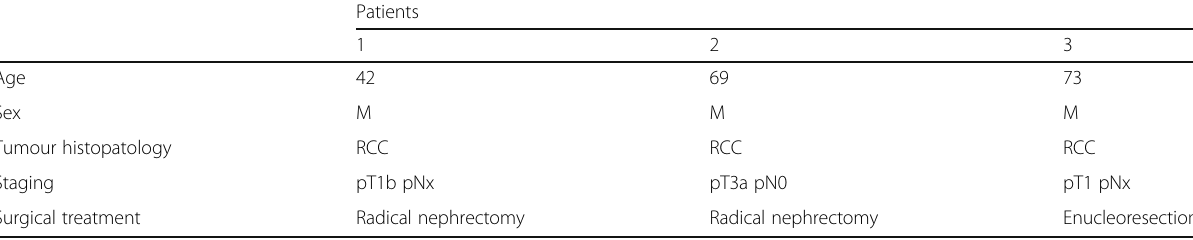
Table 1 Patients ’